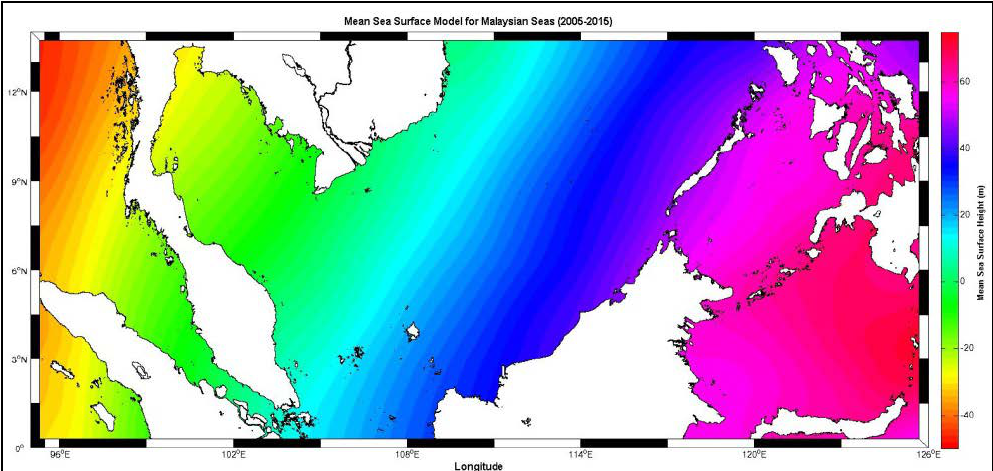
Figure 10. Localise Mean Sea Surface for Malaysian Sea